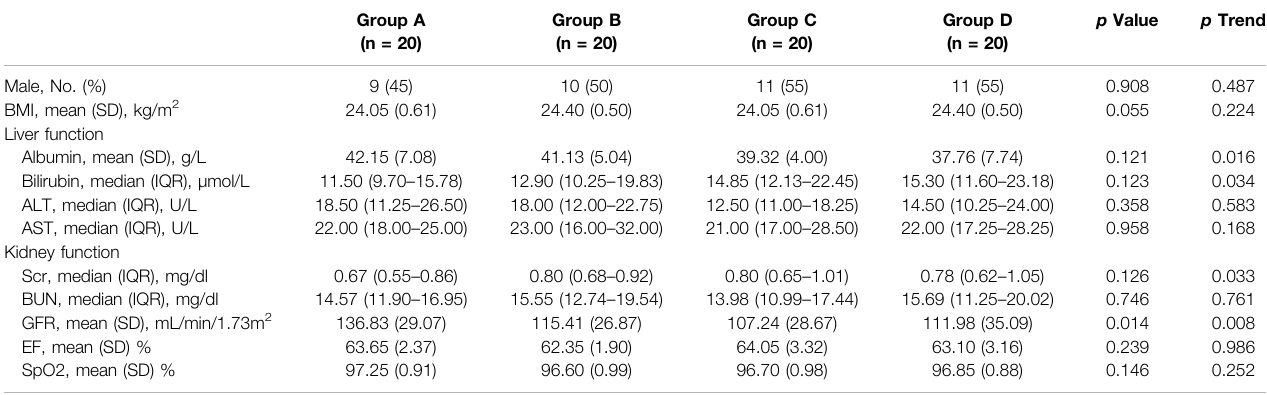
TABLE 1 | Baseline characteristics of patients in different age groups.